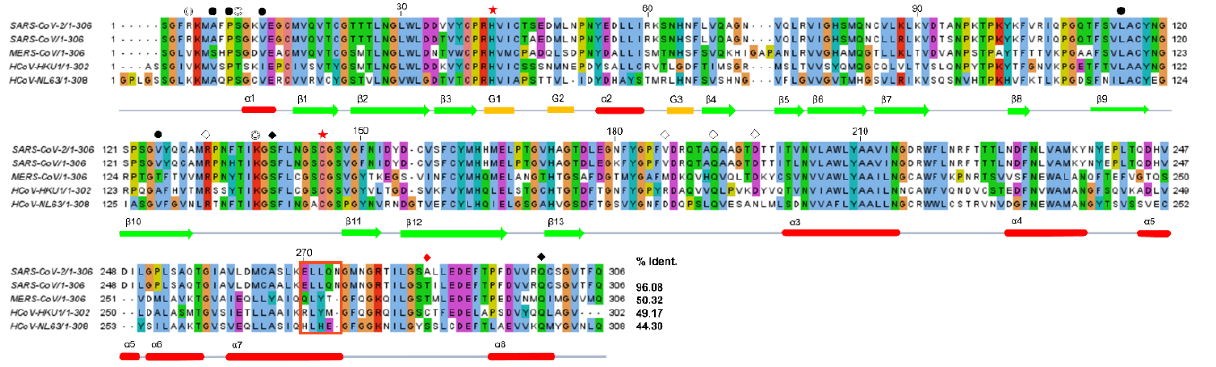
Figure 4. The sequence alignment of 3CLpros. Secondary structure elements of 3CLpro are displayed and colored in red for α -helix, in green for β -strand, and in yellow for 3 10 -helix. The sequences of 3CLpros were extracted from PDBs: 7K0F for SARS-CoV-2, 6W2A for SARS-CoV, 4YLU for MERS-CoV, 3D23 for HCoV-HKU1, and 5GWY for HCoV-NL63. The red stars indicate the catalytic residues. The residues involved in the N-terminal loop swapping are depicted with circles. The circles and the filled circles represent hydrophilic and hydrophobic interactions, respectively. The diamonds represent the interaction between the LH-loop and domain III, filled diamonds represent the dimeric interaction between Ser139 and Q299, and red represents the DM-loop